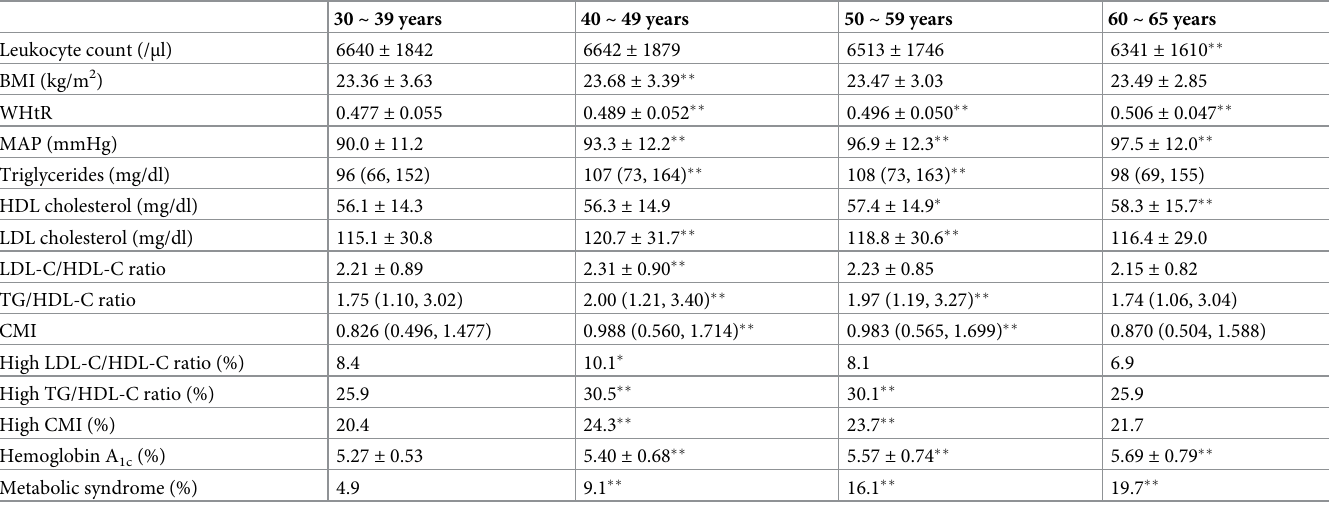
Table 7. Comparison of cardiometabolic risk factors in the different age groups of overall subjects.